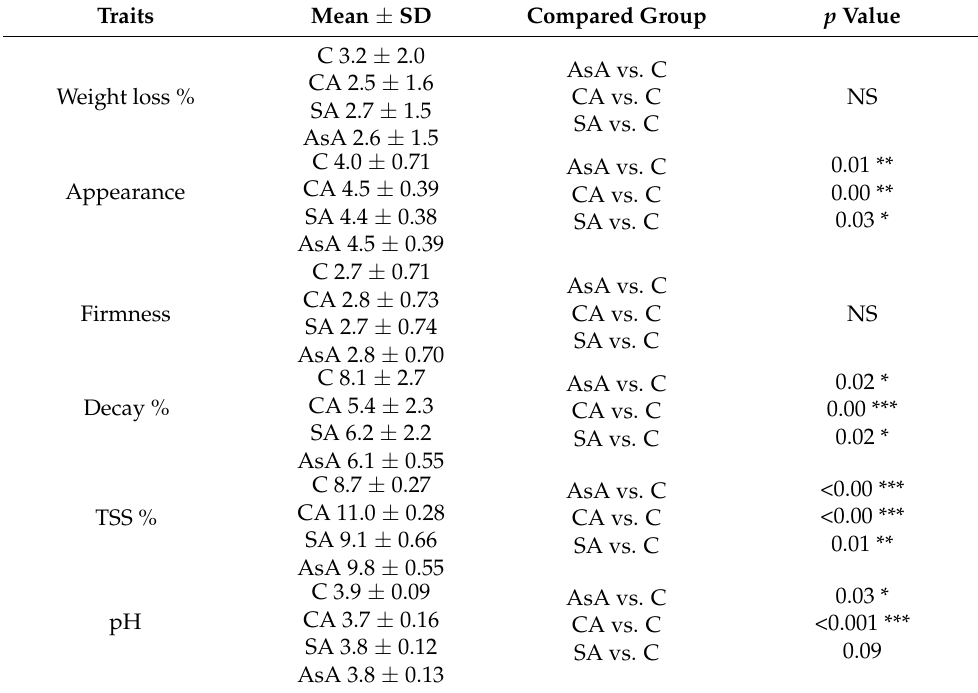
Table 2. Mean ± SD and Dunnett’s test results for morphological and physiological traits of okra pods as a function of